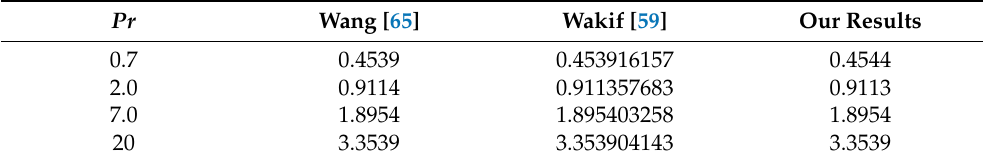
Table 2. Comparing the current numerical findings for − g (cid:48) ( 0 ) when m = 1 and all others parameter are